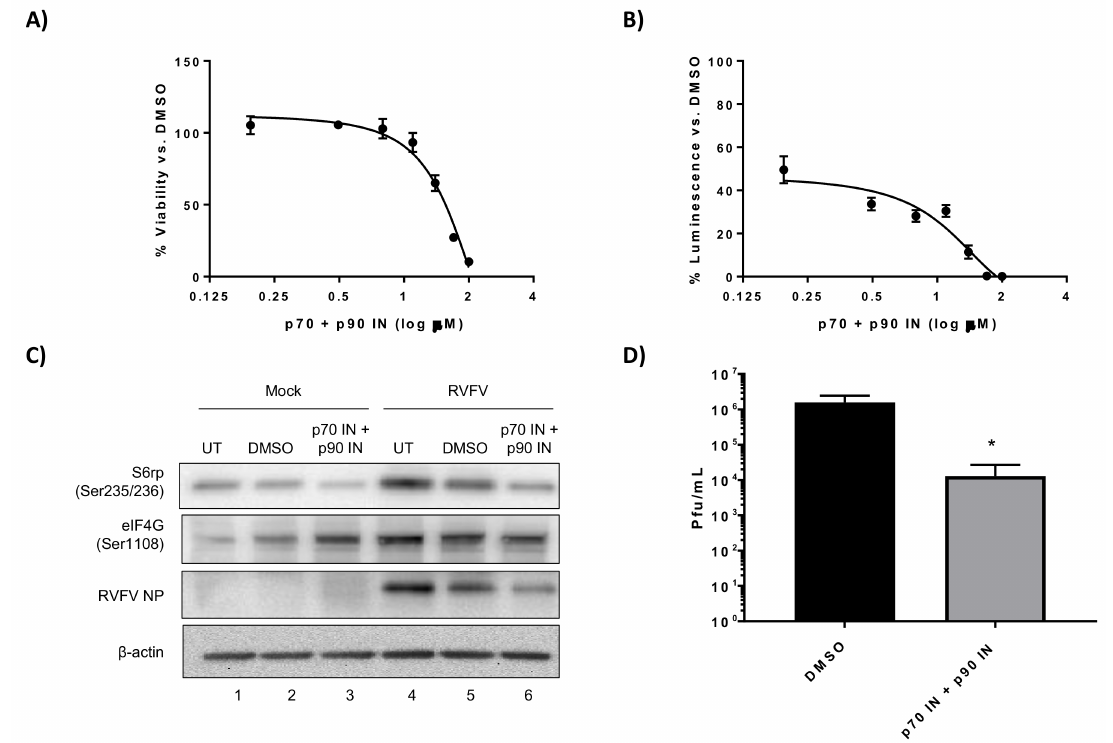
Figure 3. Combination kinase inhibitor treatment consisting of p70 S6K and p90RSK inhibitors decreases RVFV replication and NP translation. ( A ) H2.35 cells were treated with a combination of PF-4708671 p70 S6K inhibitor (p70 IN) and BI-D1870 p90RSK inhibitor (p90 IN) and cell viability analyzed at 24 h using Cell Titer-Glo. Percent viability was calculated relative to the DMSO control. The mean and SD (N = 3) are plotted; ( B ) H2.35 cells were pre-treated for 1 h, followed by a 1 h infection with RVFV MP12 ∆ NSs-Luc (MOI of 0.1). Cells were analyzed at 18 hpi using the Renilla Glo Assay. The mean and SD (N = 3) are plotted; ( C ) H2.35 cells were serum starved for 72 h and then were pre-treated with either DMSO or p70 IN/p90 IN combination (10 µ M). Cells were infected with MP12 (MOI 5) for one hour, followed by removal of viral inoculum, and addition of growth medium containing DMSO or p70 IN/p90 IN combination (10 µ M). At 18 hpi, cell lysates were collected for western blot analysis. UT = untreated. Images are representative of biological replicates; ( D ) H2.35 cells were treated and infected as described in ( C ). At 18 hpi, supernatants were collected for standard plaque assay. The mean and SD (N = 3) are plotted. * p -value ≤